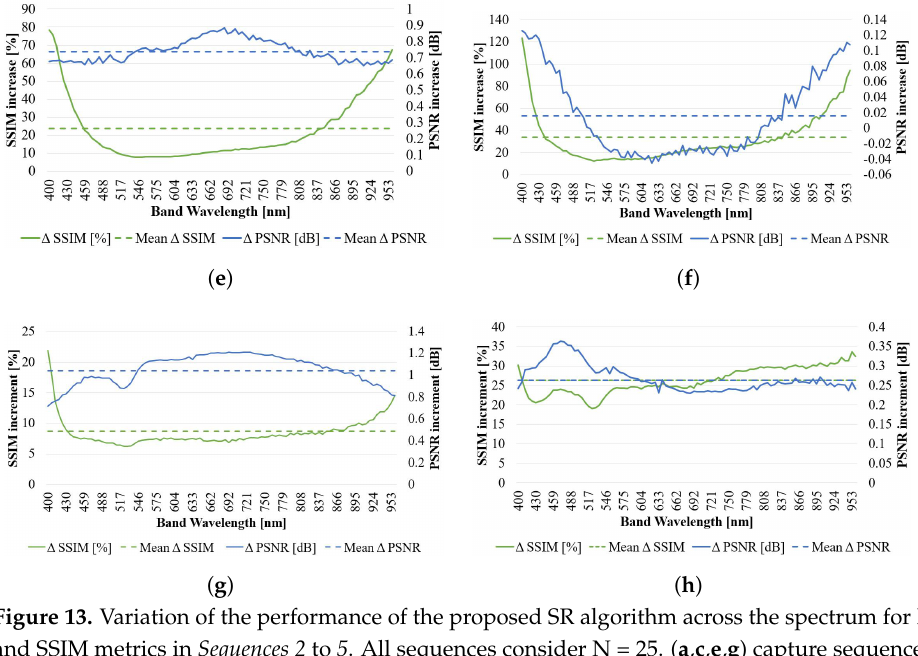
Figure 13. Variation of the performance of the proposed SR algorithm across the spectrum for PSNR and SSIM metrics in Sequences 2 to 5 . All sequences consider N = 25. ( a , c , e , g ) capture sequences 2, 3, 4, 5 respectively for EF = 2. Their corresponding result for EF = 4 is presented in ( b , d , f , h ), all at their immediate right side. Average values for both performances along the studied spectra are presented in dashed lines as a general